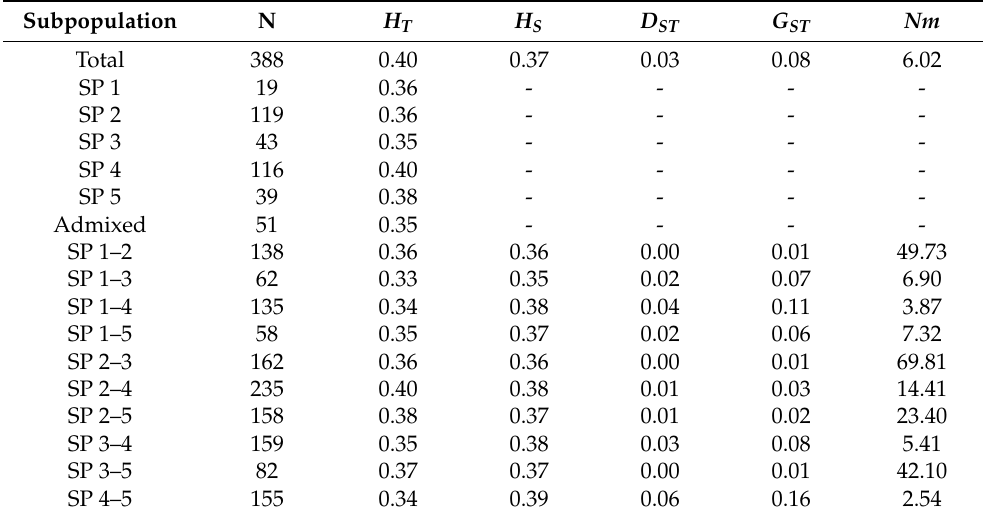
Table 1. Genetic diversity and gene flow between genetic subpopulations. Subpopulation N H